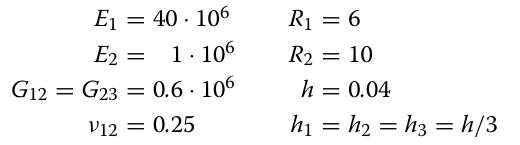
and [90 ◦ , 0 ◦ , 90 ◦ ] are considered in [16]. Here, 0 ◦ and 90 ◦ refers to the circumferential direction and the radial direction,